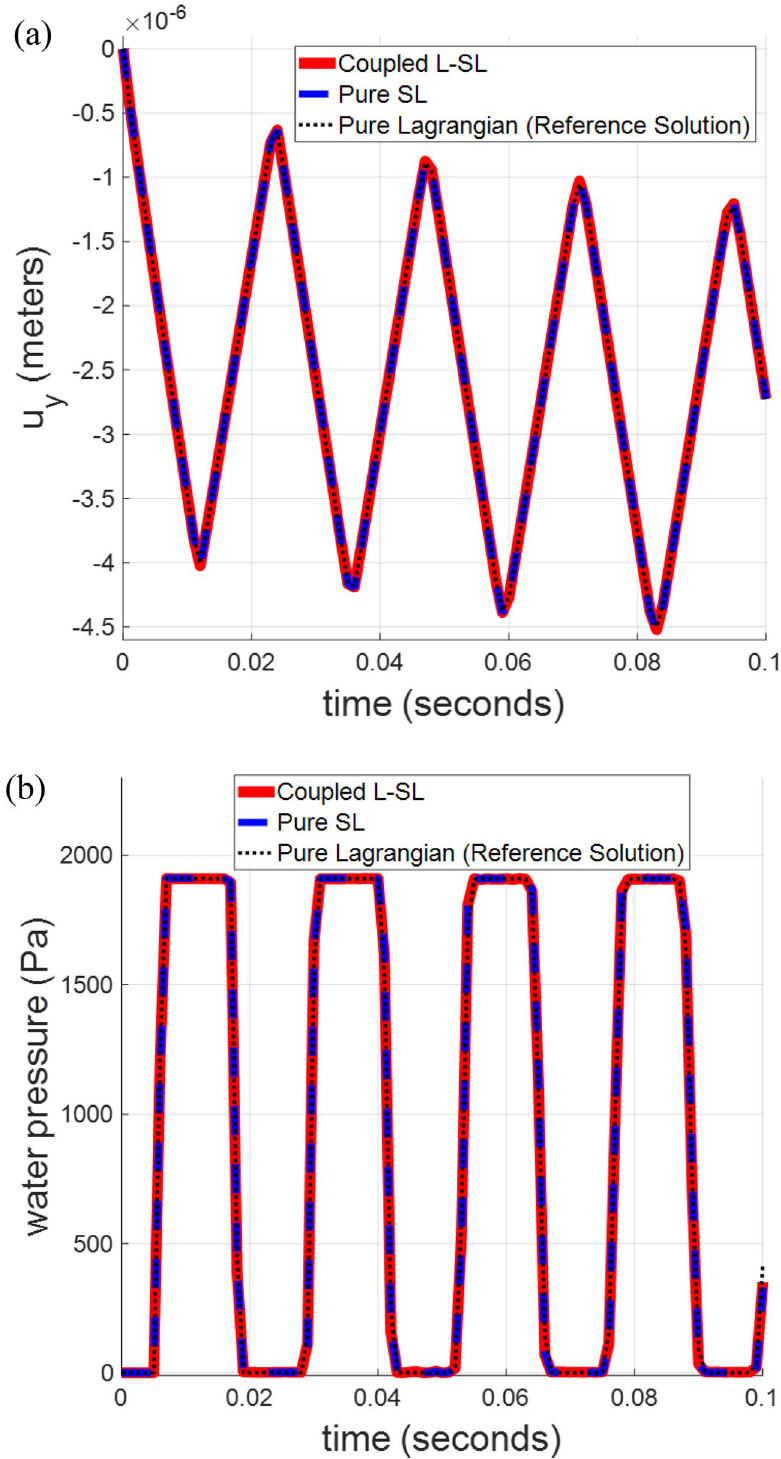
Fig. 8 Plot of solid grain displacement vs. time at the top of the soil layer ( a ); plot of water pressure vs. time at the bottom of the soil layer ( b ); both RKPM models used 401 nodes in the y ‑direction; the reference solution used was a pure L‑RK formulation with 2001 nodes in the y